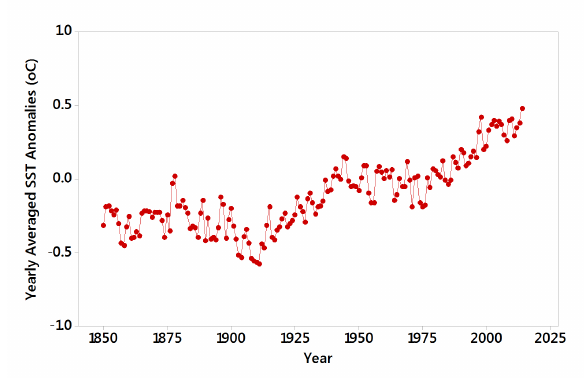
Figure 2: Hadley SST3 yearly averaged global temperature anoma- lies ( ∘ C) relative to 1961 – 1990 (Met Oflce Hadley Centre, 2015) used in this